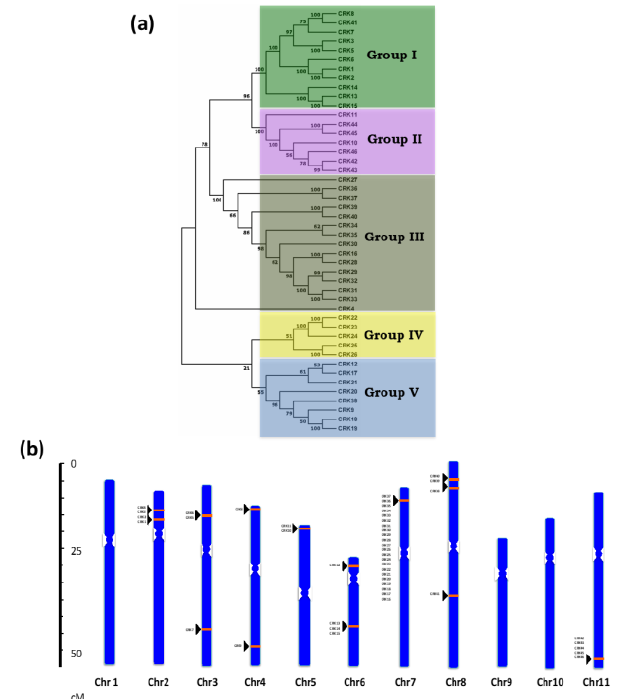
Figure 1. Phylogenetic analysis and chromosomal distribution of Phaseolus vulgaris CRK genes. ( a ) Protein sequences of 46 P. vulgaris Cysteine (C)-rich receptor-like kinase (CRK) homologs were identified in the Phytozome database. The phylogenetic tree was constructed using MEGA 7 software with the neighbor-joining (NJ) tree method with 1000 bootstrap values. ( b ) CRK genes localized to Phaseolus chromosomes. The chromosomes are represented by blue bars that are distributed numerically. The orange bands with black triangles indicate the CRK position on the chromosome.